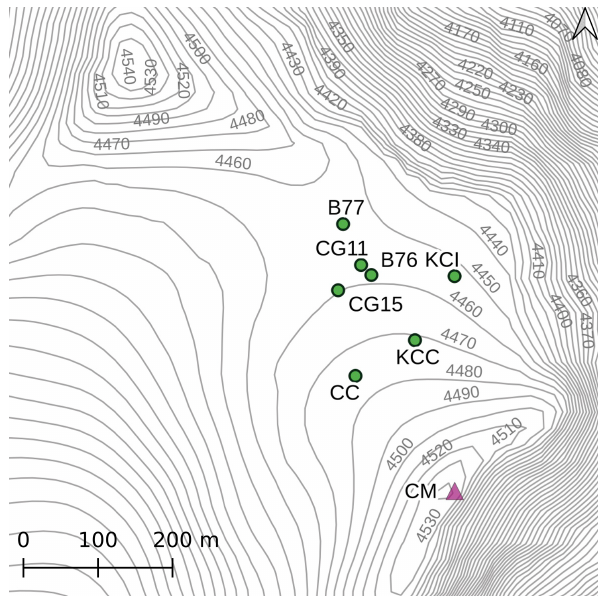
Figure 2. The site of Colle Gnifetti and the location of the ice cores considered in the present work. CG03 and CG15 ice core share the same location therefore CG03 is not shown. The position of Ca- panna Regina Margherita (CM) is also